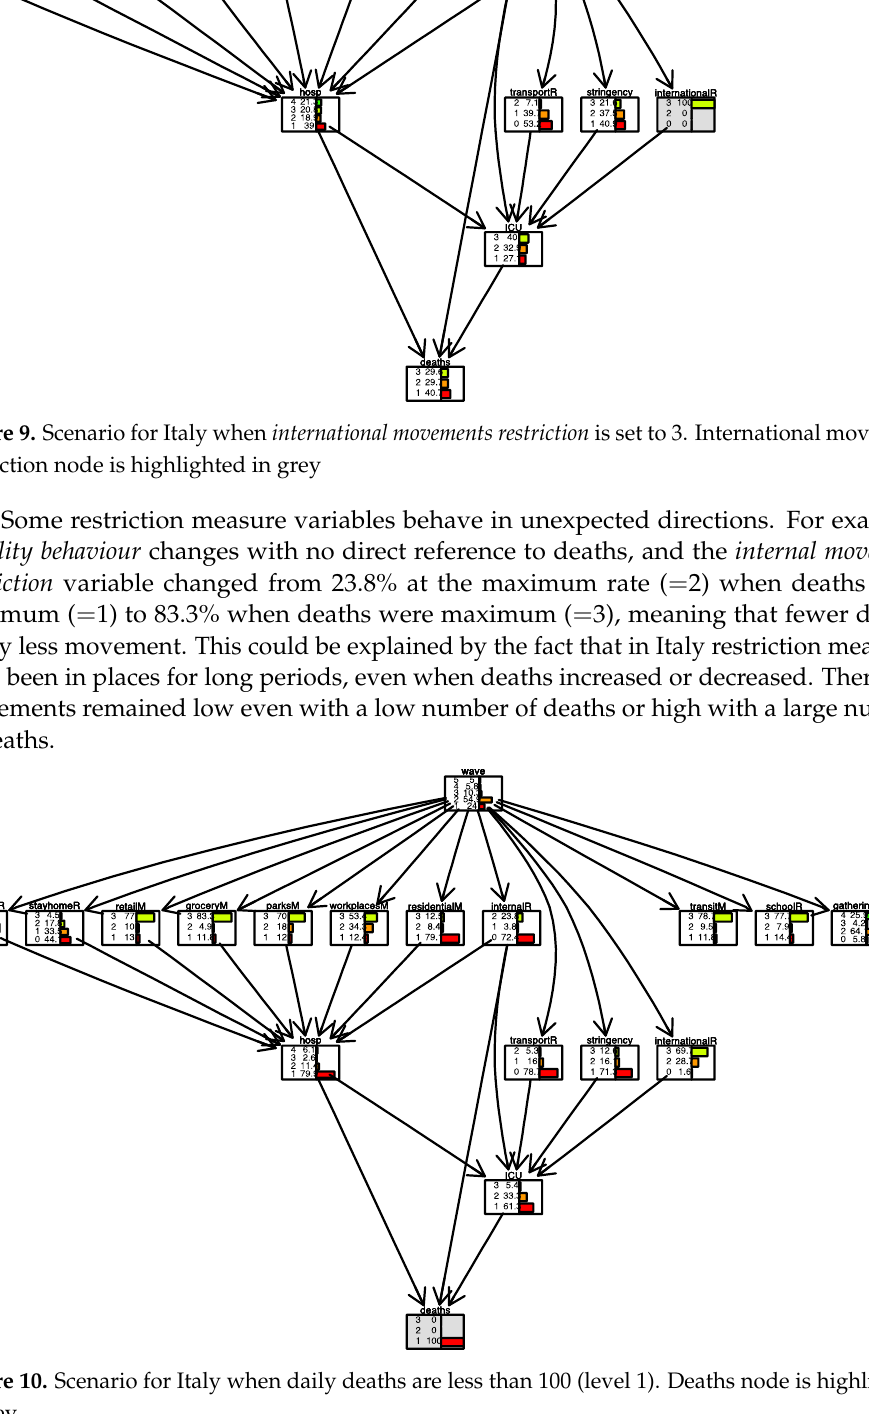
Figure 10. Scenario for Italy when daily deaths are less than 100 (level 1). Deaths node is highlighted in